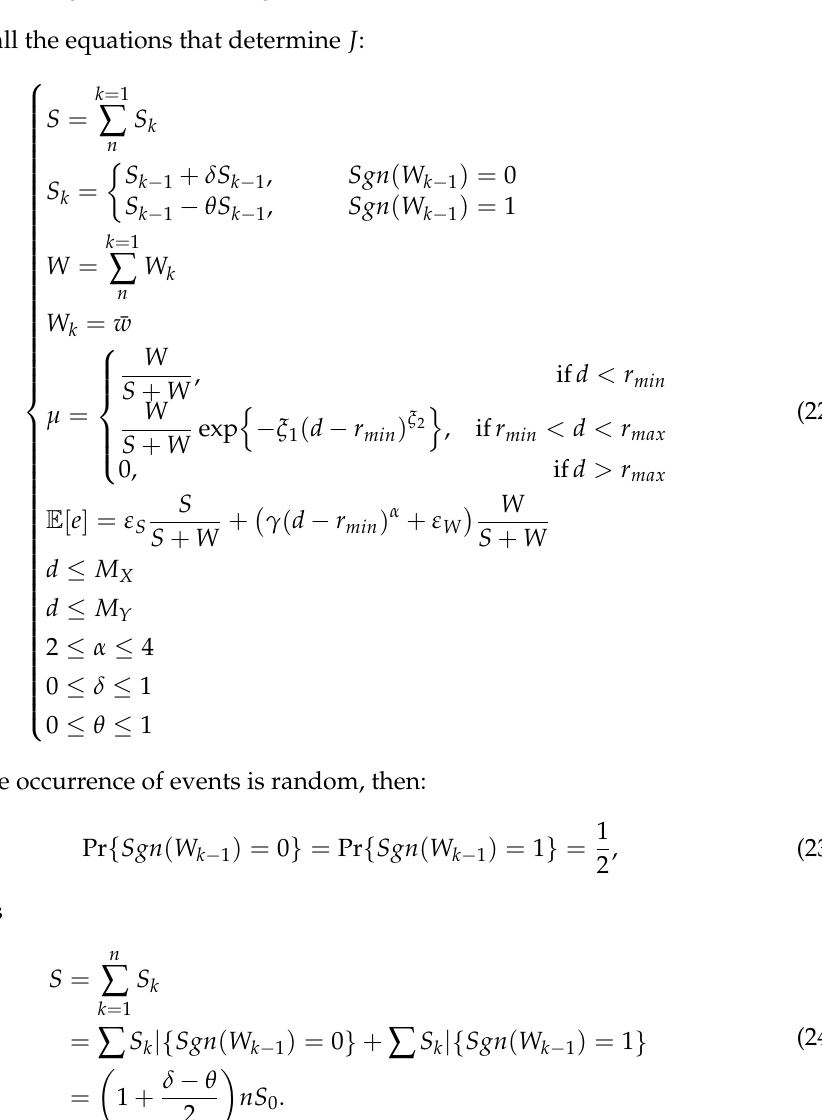
Figure 4. The liner region for different Sigmoid